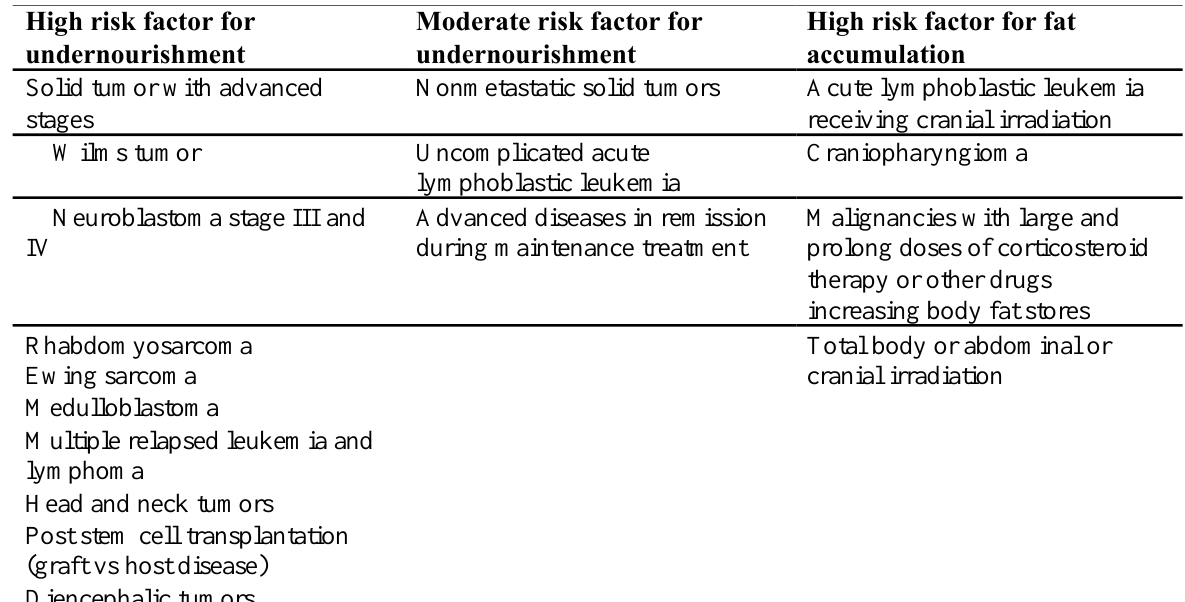
Table 1. Tumor types associated with malnutrition for pediatric oncology patients. Adapted from Bauer et al.